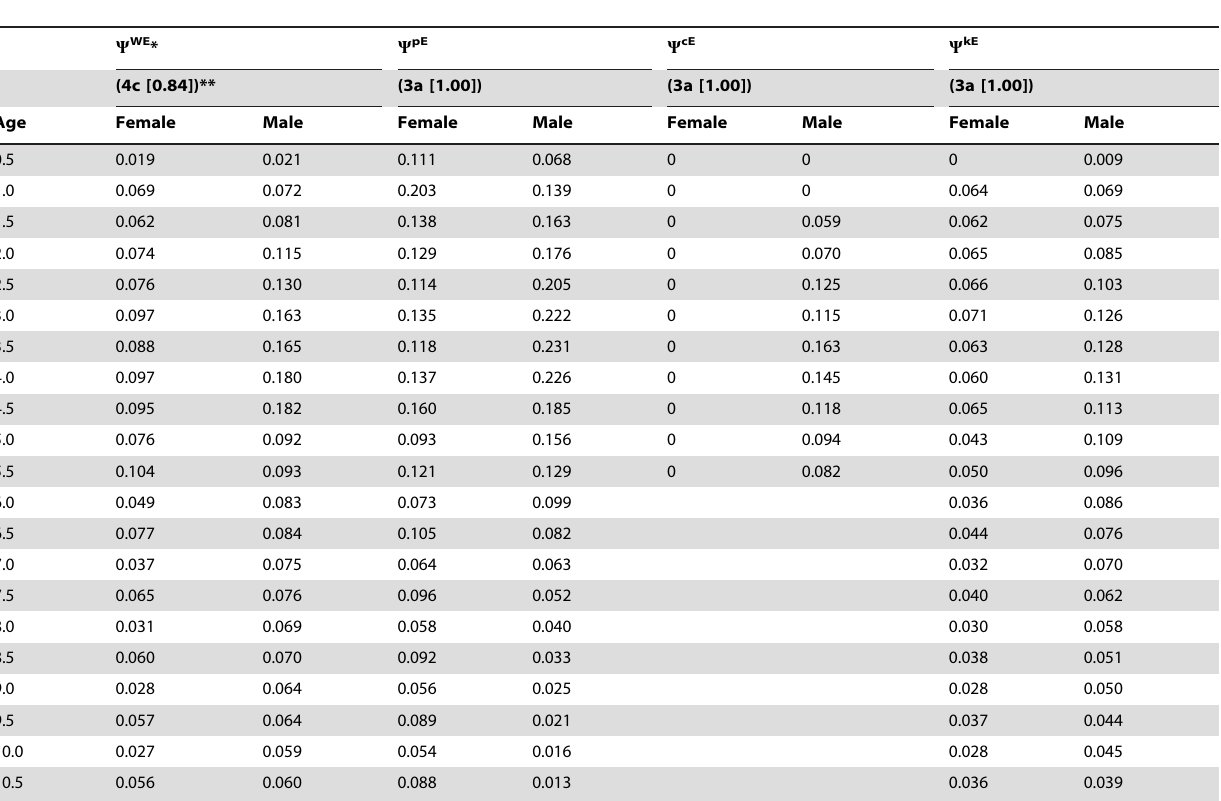
Table 6. Estimated seasonal age- and sex-specific occupancy probabilities for western DPS Steller sea lions being in their non- natal DPS during breeding (whole number) and non-breeding ( + 0.5) seasons; the estimates were derived from the best of 9 models for each set of estimates (see Table